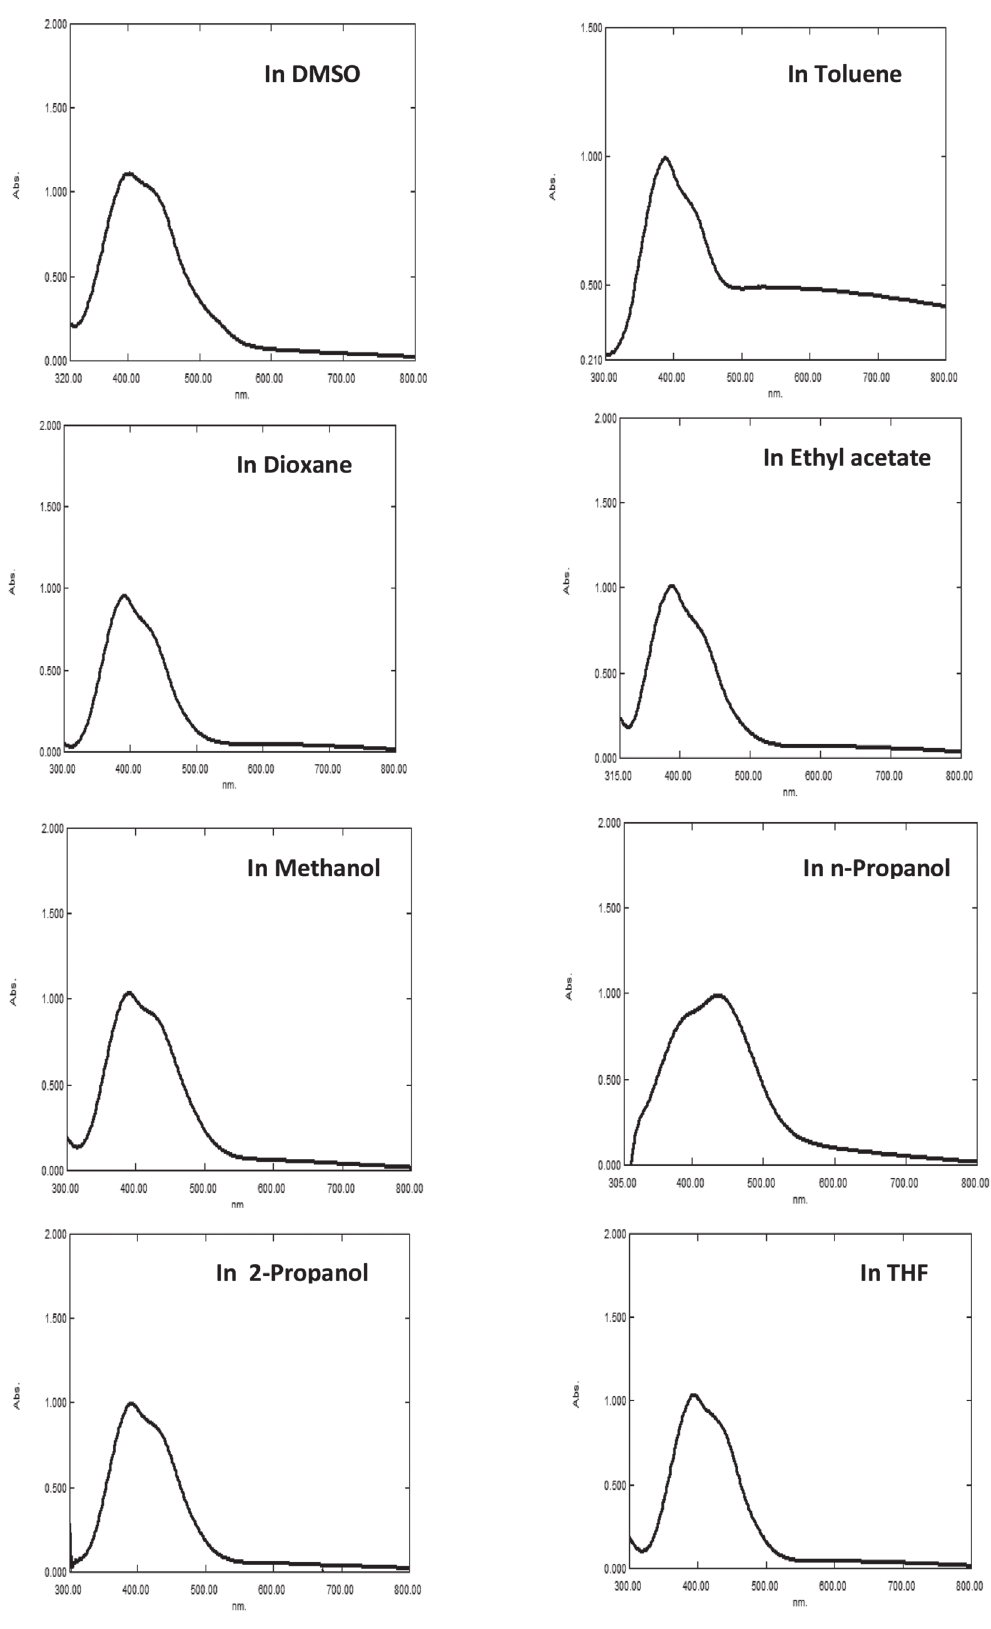
Figure 16: Compilation of the spectra for 4-APAP measured in the referred